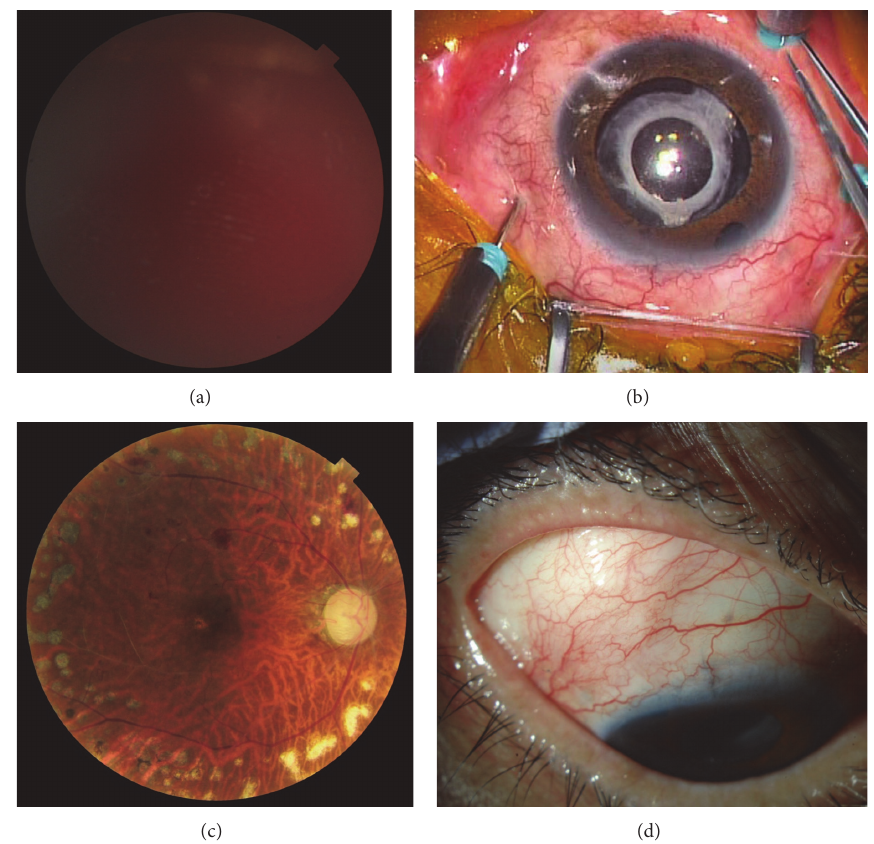
Figure 1: Representative example of proliferative diabetic retinopathy (PDR) complicated by neovascular glaucoma (NVG) (Patient 12; see Table 1). Fundus, anterior segment, and intraoperative photographs of the eye of a 61-year-old man with PDR/NVG. The eye underwent 25- gauge microincision vitrectomy surgery (25GMIVS) after trabeculectomy. (a) Preoperative photograph of the fundus. We could not